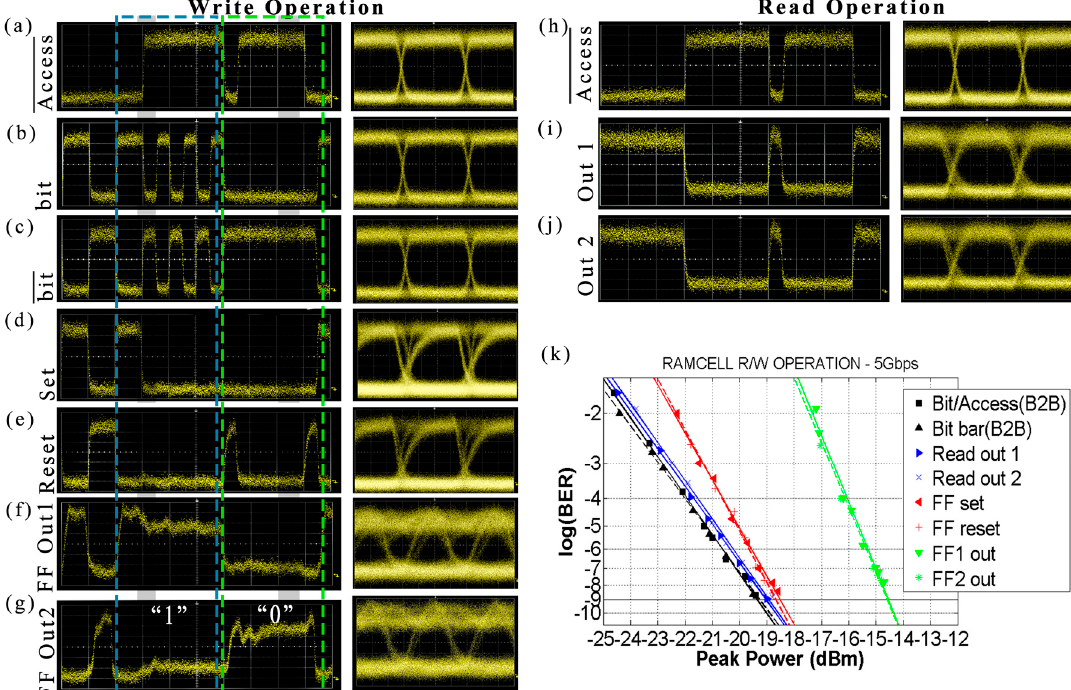
Figure 4. Experimental results of RAM cell demonstration: ( a – g ) Time traces (400 ps/div) and eye diagrams (50 ps/div) for the WRITE operation; ( h – j ) Time traces (400 ps/div) and eye diagrams (50 ps/div) for the READ operation; ( k ) BER measurements for the READ/WRITE operation at 5 Gb/s.